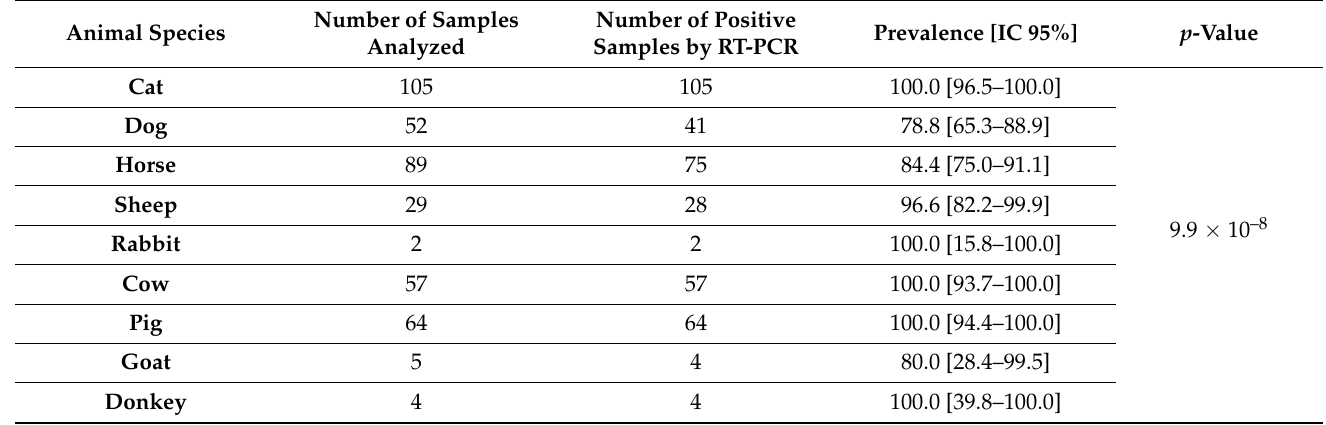
Table 3. Comparison of prevalence based on real-time PCR between animal species.